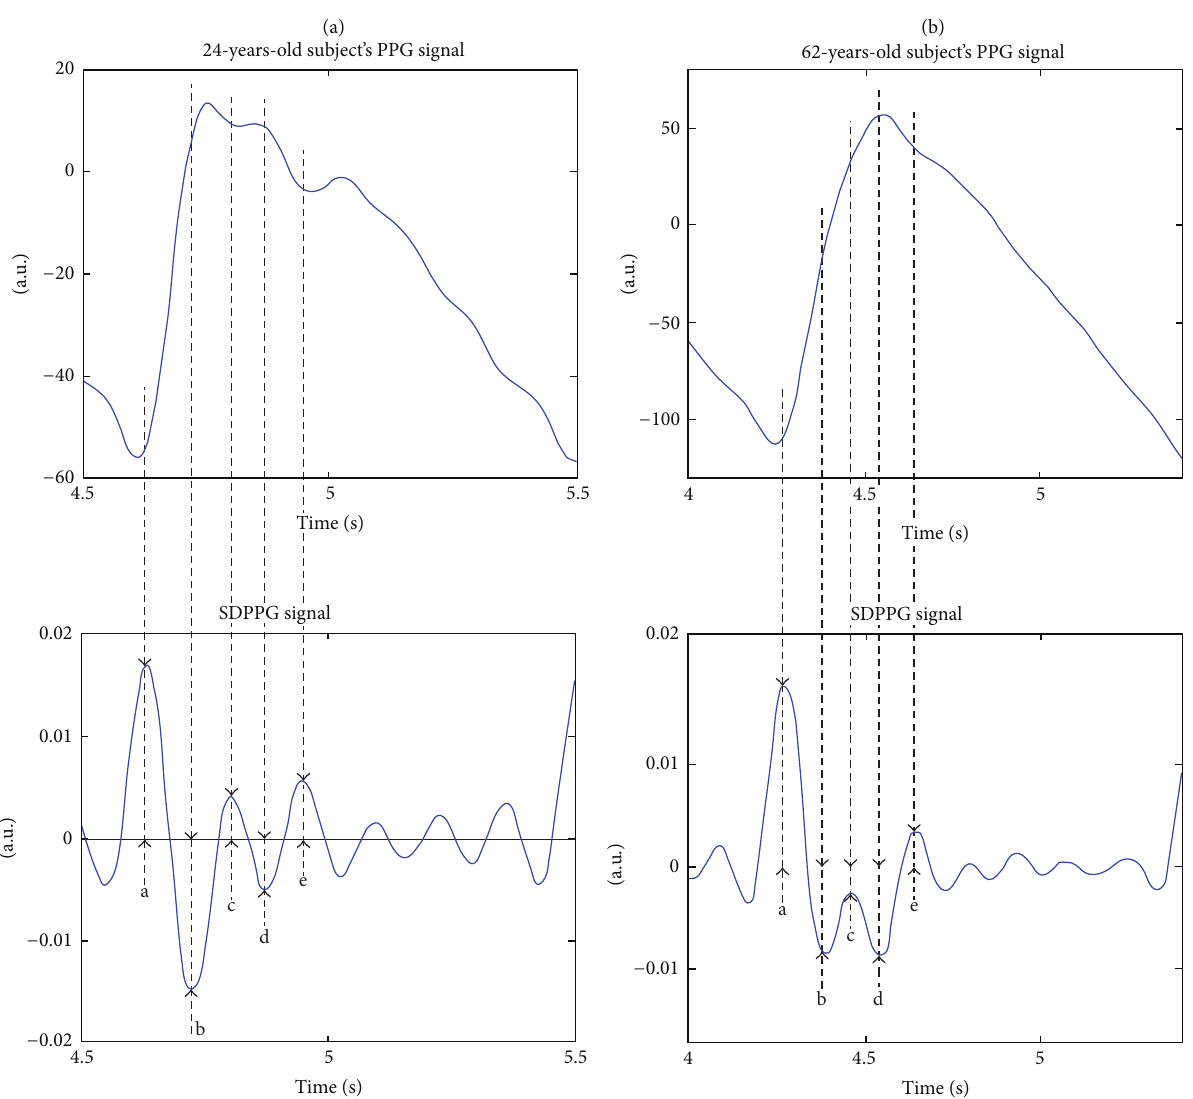
Figure 1: The finger PPG signal and its second derivative with distinct waves “a”, “b”, “c”, “d”, and “e” of 24-year (a) and 62-year-old (b) subjects.